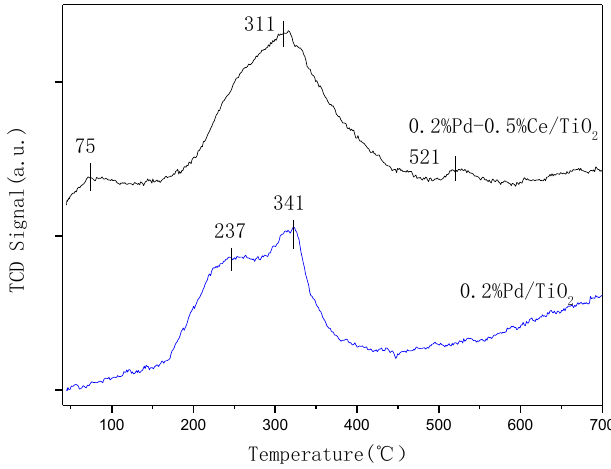
Figure 4. H 2 -TPR profiles of Pd-Ce/TiO 2 catalysts.